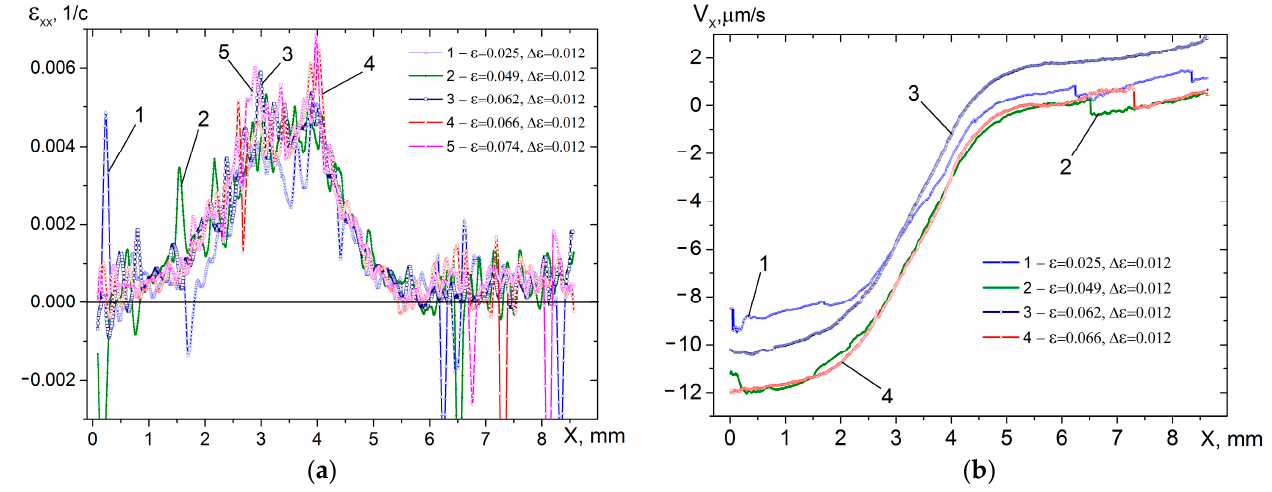
Figure 8. Spatial distribution of longitudinal deformation component along the midline ( a ) and longitudinal displacement velocity ( b ) at the first stage.